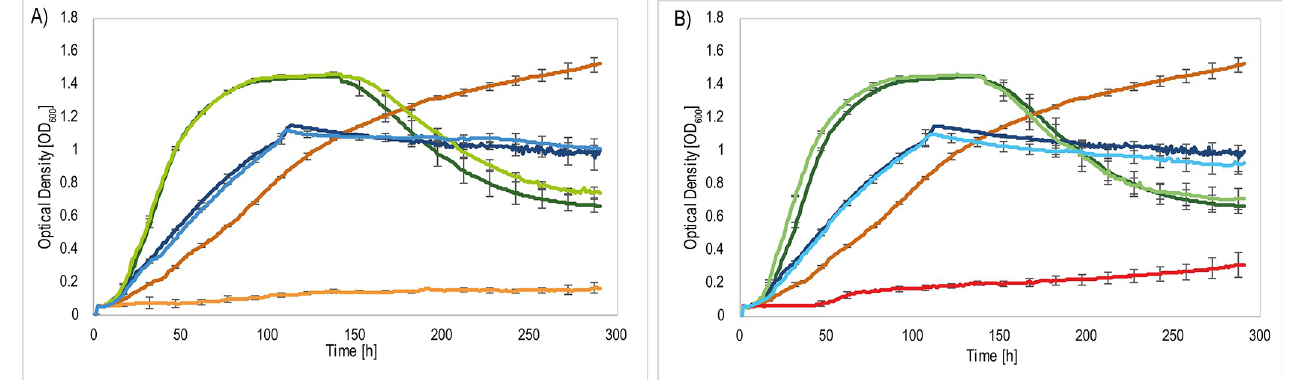
Fig 4. Growth curves of the wildtype V . paradoxus TBEA6 wildtype in comparison to the mutants Δ ech-20 and Δ ech-30 . Cells were cultivated in MSM containing 60 mM gluconate, TDP or 3SP. V . paradoxus TBEA6 with gluconate (dark green), V . paradoxus TBEA6 with TDP (orange), V . paradoxus TBEA6 with 3SP (dark blue) (in A and B), A) V . paradoxus TBEA6 Δ ech-20 with gluconate (light green), V . paradoxus TBEA6 Δ ech-20 with TDP (yellow), V . paradoxus TBEA6 Δ ech-20 with 3SP (light blue). B) V . paradoxus TBEA6 Δ ech-30 with gluconate (light green), V . paradoxus TBEA6 Δ ech-30 with TDP (red), V . paradoxus TBEA6 Δ ech-30 with 3SP (light blue). The experiment was performed in triplicate. Standard deviations are indicated as error bars.